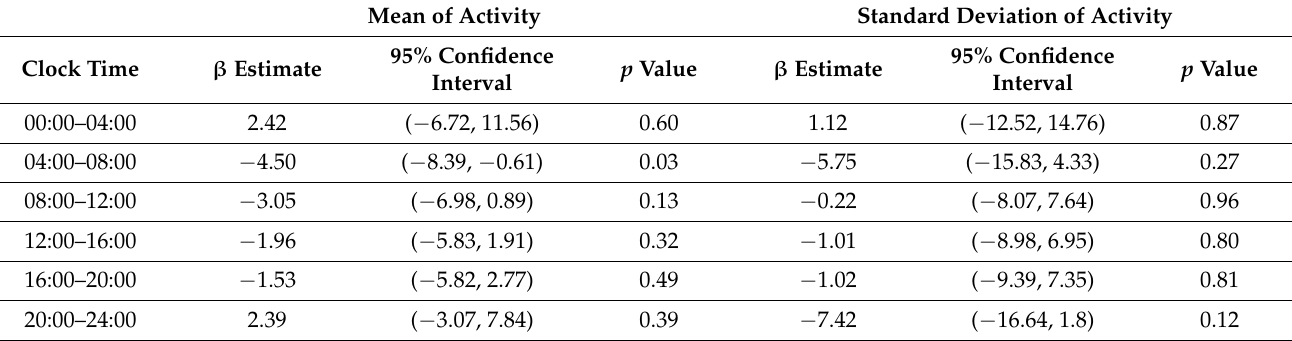
Figure 2. Mean and standard deviation of daily log activity counts stratified by the Pittsburgh Fatigability Scale (PFS) at 4-h time bin intervals. Solid line represents greater perceived physical fatigability (PFS ≥ 15); dotted line represents lesser perceived physical fatigability (PFS < 15). Table 3. Multivariate quantile regression models of mean daily activity and standard deviation of daily activity across four-hour time intervals